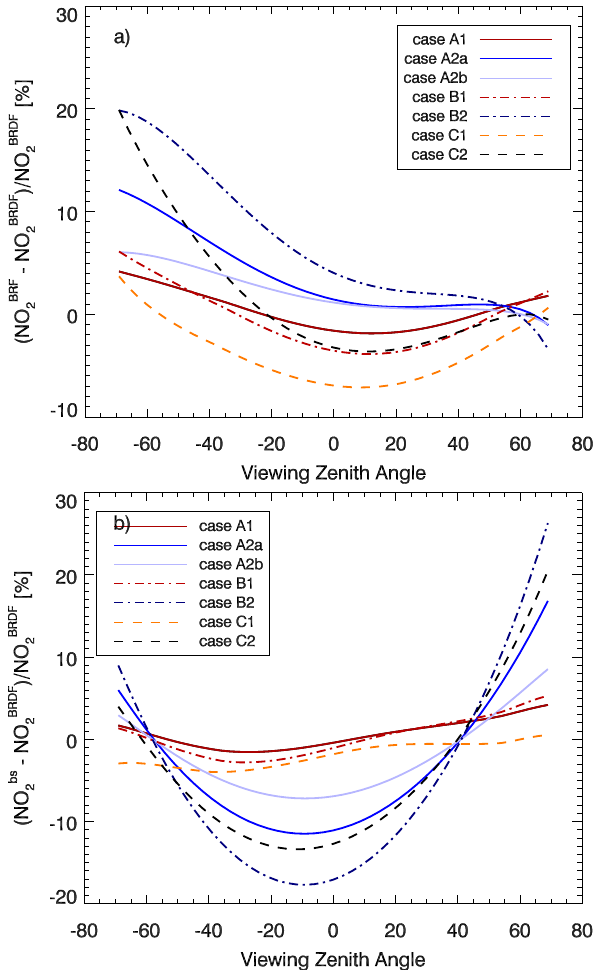
Fig. 9. Relative differences of (a) NO BRF 2 and (b) NO bs 2 compared to NO BRDF 2 for the OMI orbit marked in Fig. 5 for cases in Table 1 (A1, B1 and C1 are summer cases; A2a, A2b, B2 and C2 are winter cases).